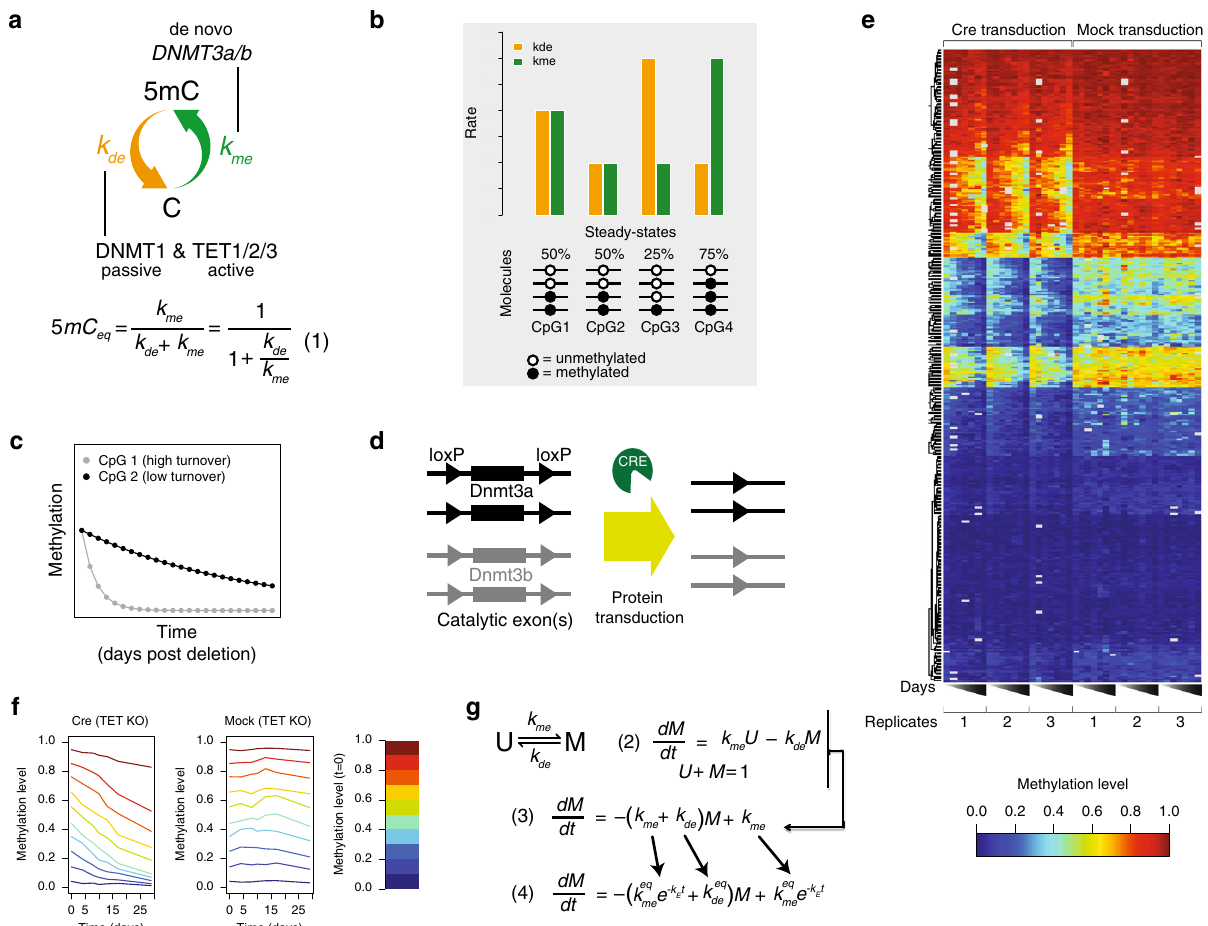
Fig. 1 A dynamical model and cellular system to infer methylation and demethylation rates. a Graphic representation of methylation and demethylation rates. The orange and green arrows represent k de and k me , respectively. The enzymes responsible for in fl uencing rates are noted. The ratio of rates determines overall methylation levels (Equation (1) below). b Example steady-state methylation levels resulting from different k me (green) and k de (orange) combinations. Higher methylation levels are established when k me is larger than k de , while low methylation levels represent the opposite. CpGs with the same steady state can have different rates as shown here for 50%. c Theoretical trace of methylation loss over time post Cre transduction for two CpGs with similar steady states. d Cellular system for genetic ablation of k me . Dnmt3a and Dnmt3b with loxP sites fl anking catalytic exons. Cre protein transduction allows for ef fi cient genetic deletion of all four alleles. e Heatmap of methylation levels for 405 CpGs as measured by amplicon bisul fi te sequencing. The left half represents methylation levels for triplicate experiments measured 0, 4, 8, 10, 13, 17, and 29 days post Cre transduction. The right half represents triplicates for mock-treated samples. f CpGs were binned based on starting methylation in 10% increments, and the mean decay over triplicates for Cre-transduced samples (left) and mock samples (right) are shown. g Dynamical model for DNA methylation and implementation of the exponential dampening factor k e for affecting k me over time (Eqs. (2) – (4)). See text and “ Methods ” for